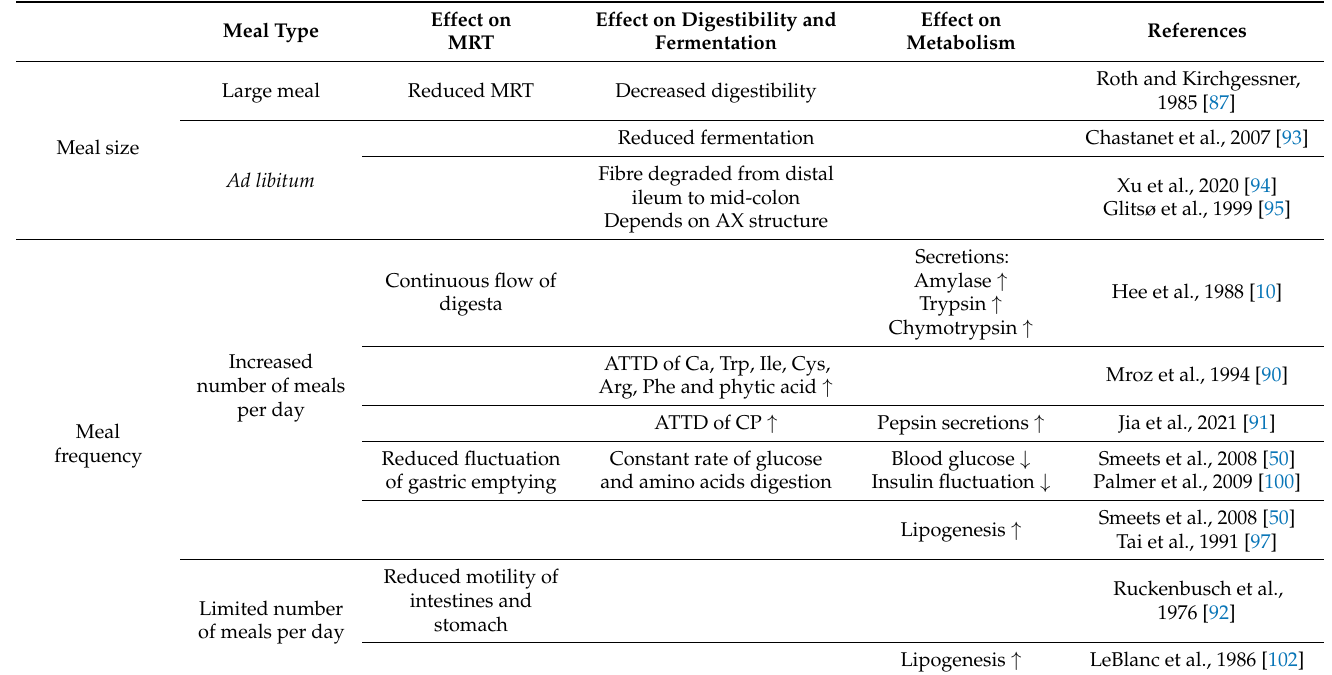
Table 2. Effect of meal size and frequency on mean retention time (MRT), digestibility, fermentation and